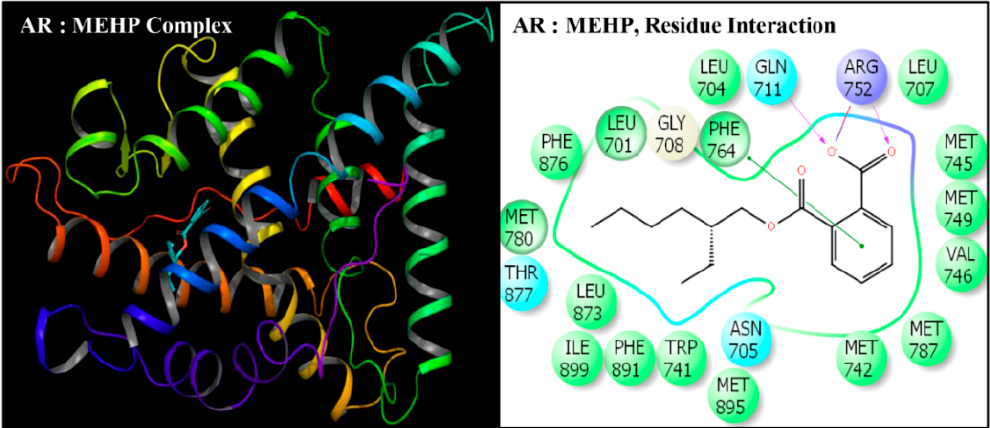
Figure 3. Ribbon diagram representing the docking pose of human androgen receptor (AR) with mono-(2-ethylhexyl)phthalate (MEHP) (left panel). The interactions of ligand (MEHP) with amino-acid residues in the binding pocket of AR (right panel).